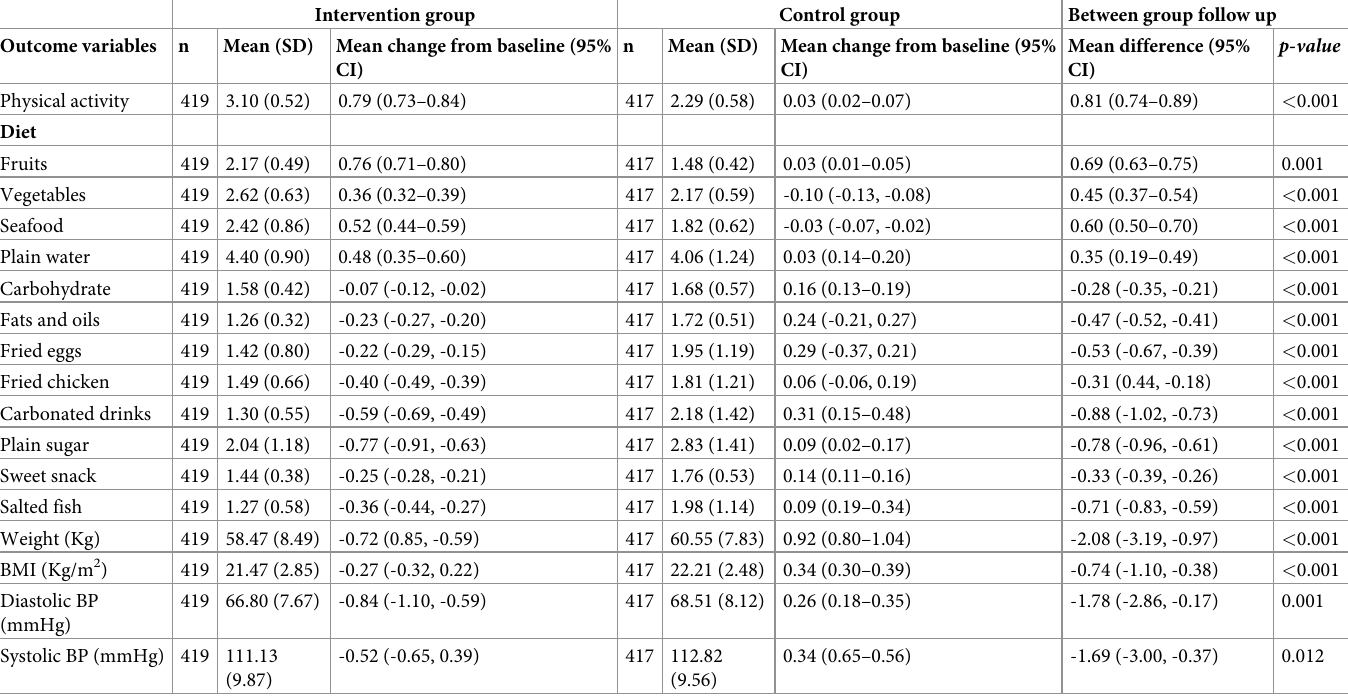
Table 3. Changes from baseline to six months and comparison between groups post intervention.